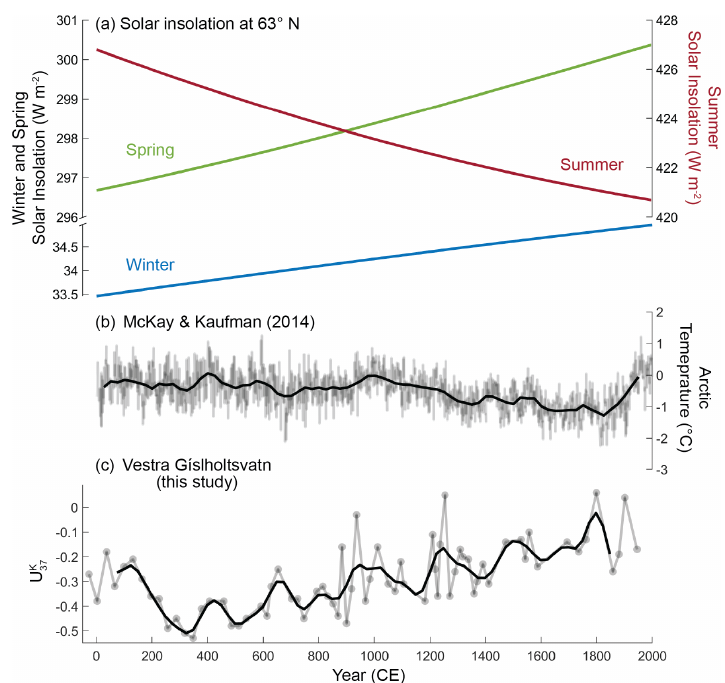
Figure 6. (a) Changes in solar insolation at 63 ◦ N for winter (DJF), spring (MAM), and summer (JJA) are shown for the past 2000 years (Laskar et al., 2004). In addition, (b) a compilation of Arctic temperature reconstructions (McKay and Kaufman, 2014) is shown for compar- ison with the (c) winter–spring temperature reconstruction from VGHV. The thick black lines correspond to low-pass filters (every 25 years) applied to the Arctic dataset and VGHV